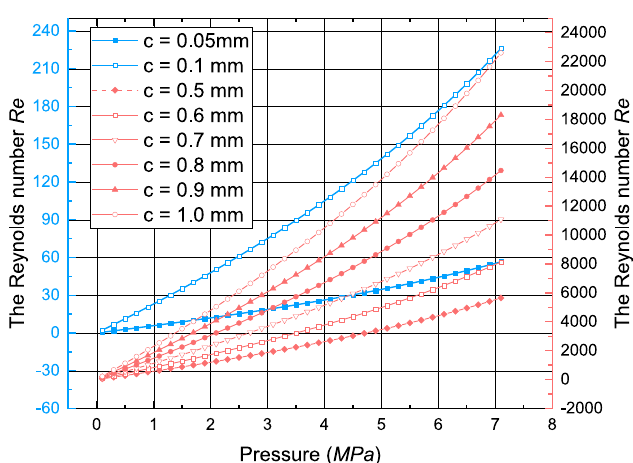
Fig. 3. Reynolds number distribution vs parameters.